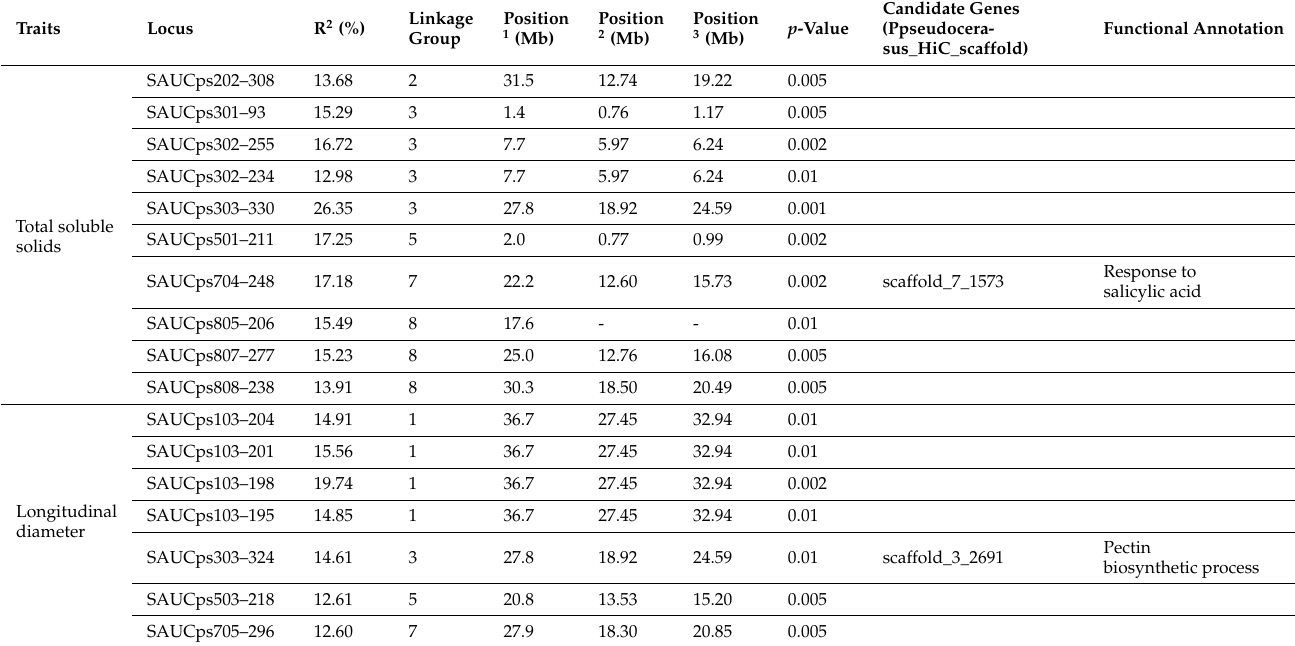
Table 3. Three fruit traits associated with SSR loci and candidate